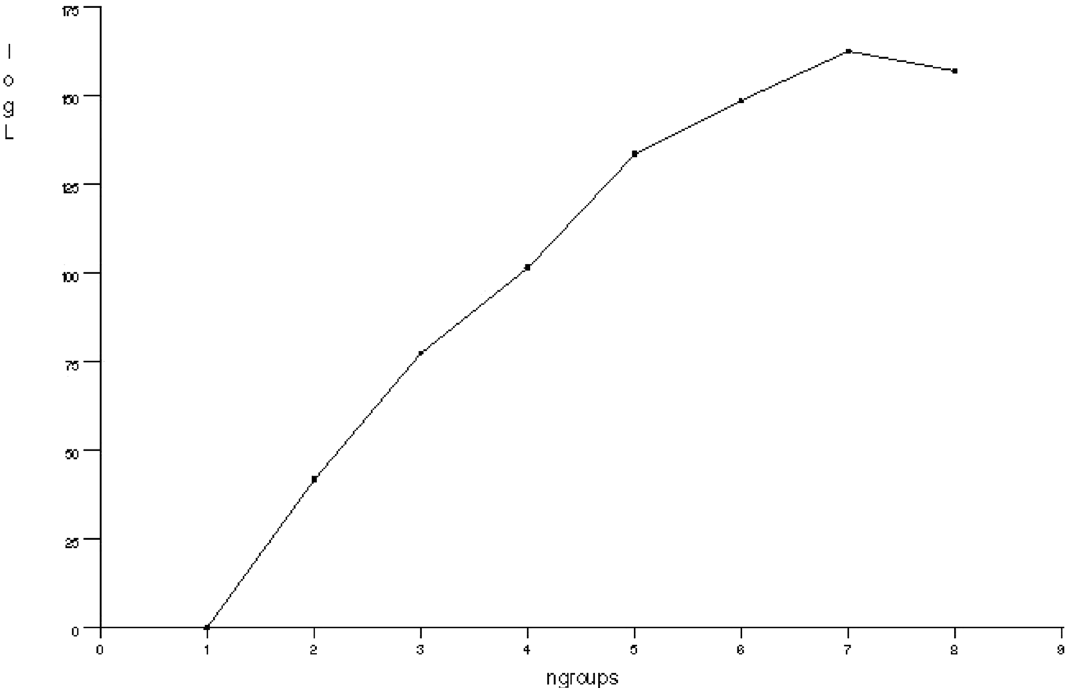
Figure 4. Log-Likelihood function, indicating the number of clusters formed by the Ward-MLM strategy. UENF, municipality of Campos dos Goytacazes, genotypes of the S 1 inbred families of guava trees studied (Table 3). As for the qualitative traits, the descriptor about the branch altitude was (6.5%) erect and (65.5%) pending. The color trait of the stem was (39.2%) green; (42.6%) yellow green; and (18.1%) dark red. There is, in the descriptors, a strong differentiation in the magnitude of the anthocyanin presence in leaves, with percentages of 16.4% and 83.6%, respectively. With respect to the intensity of anthocyanin staining in